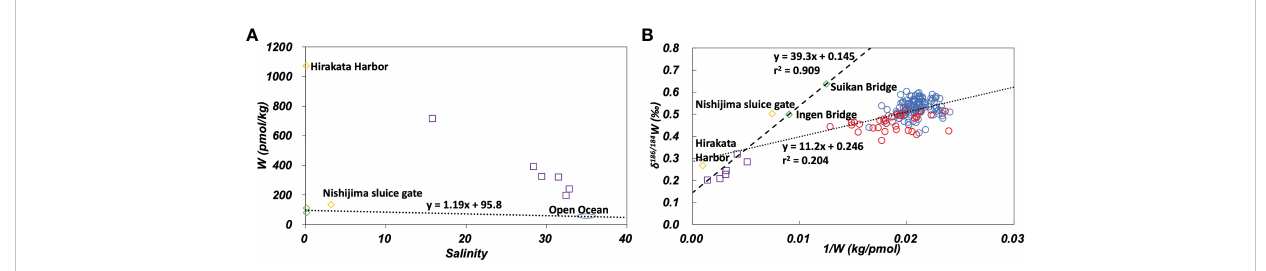
FIGURE 6 (A) : W concentration plotted against salinity. The dotted line passes the average of the Uji River and the average of the open ocean. (B) : d 186/184 W plotted against the inverse W concentration. The dashed line is the regression line (eq. 3) for data of the Uji River-Yodo River-Osaka Bay system. The dotted line is the regression line (eq. 4) for the open ocean and marginal seas data. Green diamonds: the Uji River, yellow diamonds: the Yodo River, purple squares: Osaka Bay, blue circles: the open ocean, red circles: marginal